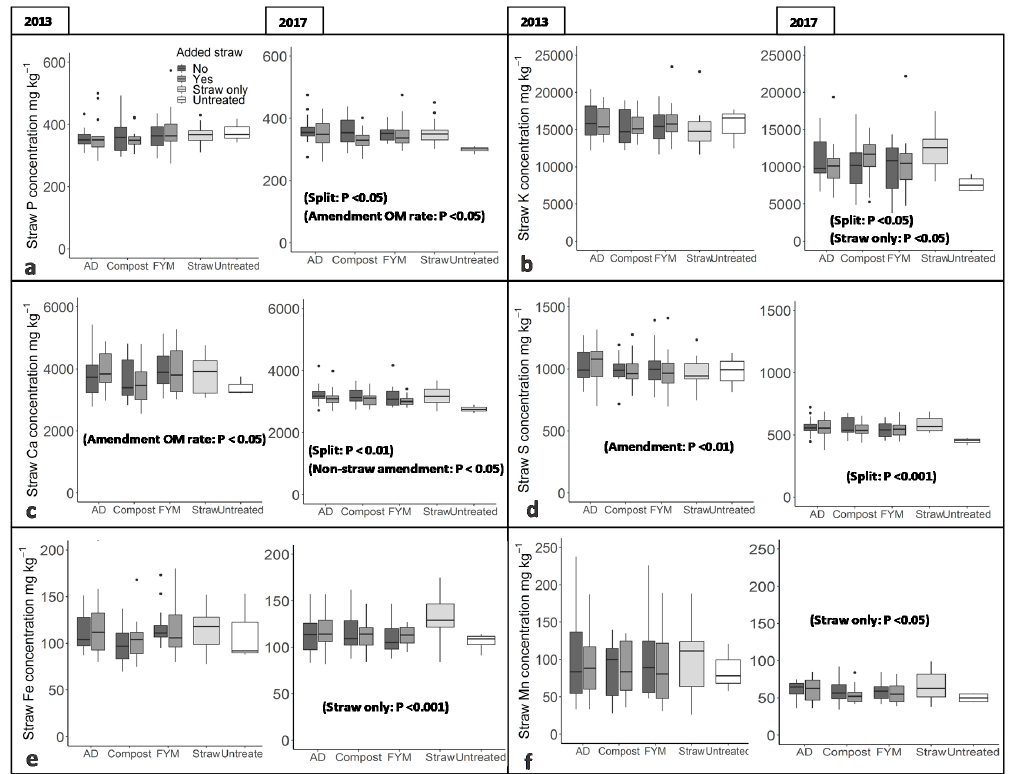
Figure 2. Median ( ± 25th and 75th quartiles, 95% CI and outliers) straw concentration of ( a ) phosphorus, Figure 2 . Median (± 25th and 75th quartiles, 95% CI and outliers) straw concentration of ( a ) ( b ) potassium, ( c ) calcium, ( d ) sulfur, ( e ) iron, and ( f ) manganese in the baseline year 2013 and in